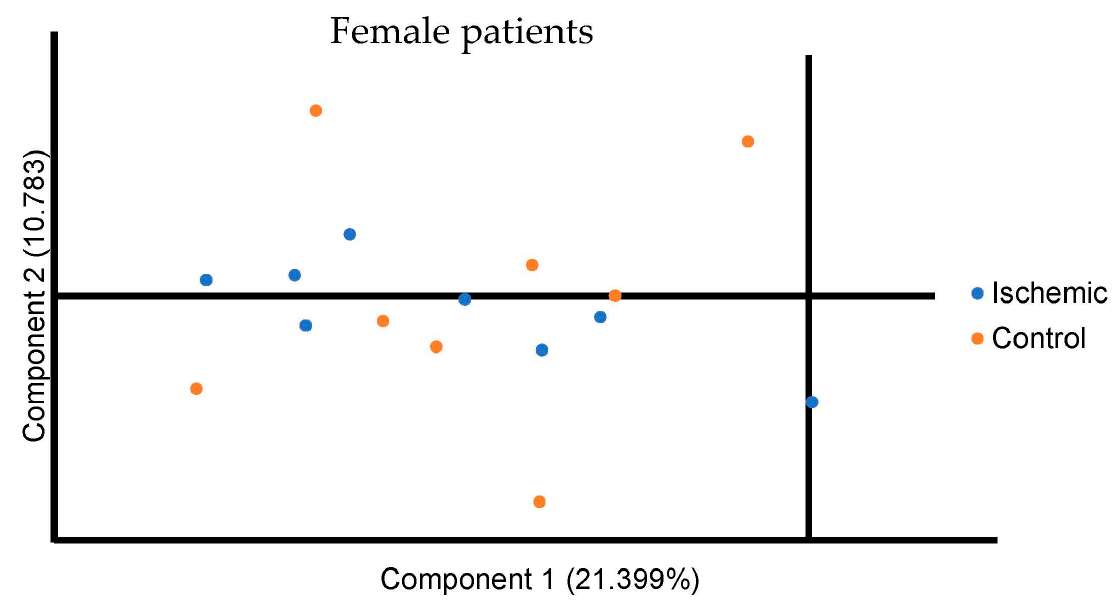
Figure 1. Principal Component Analysis for all metabolites in the female ischemic and control population. Component 1 is plotted on the x axis and Component 2 is plotted on the Y axis. Component 1 encompassed 21.399% of the variation between participants and Component 2 encompassed 10.783% of the variation between participants.